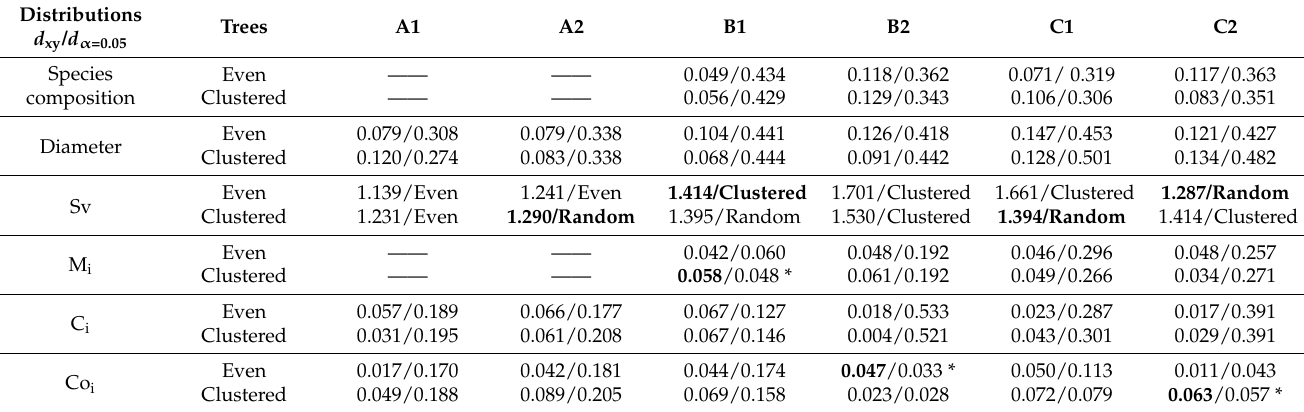
Table 2. Similarity test of even and clustered trees with the stands and the Sv results. ( d xy / d α = 0.05 ; * indicates significant